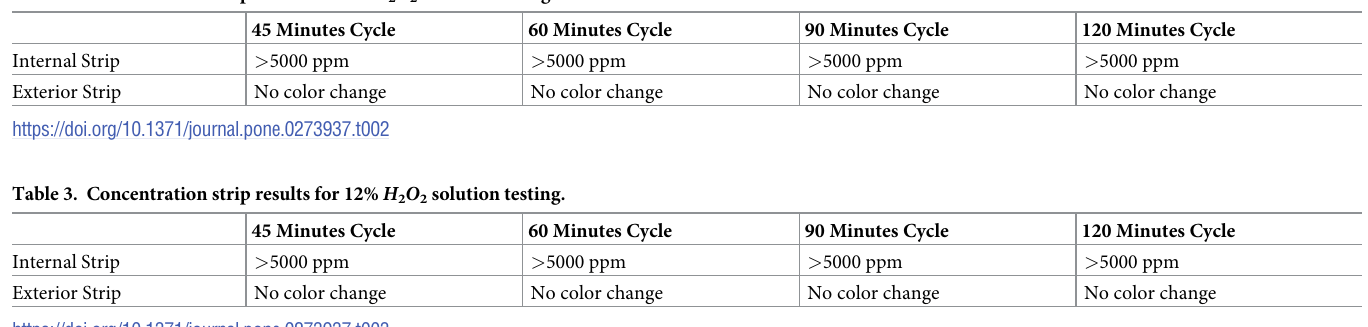
Table 2. Concentration strip results for 3% H 2 O 2 solution testing.